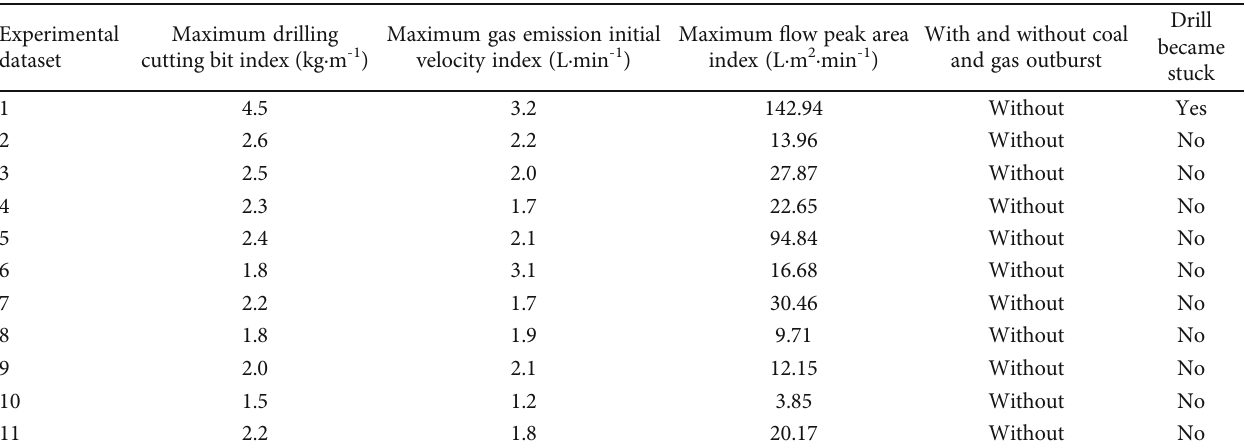
Table 2: Experimental